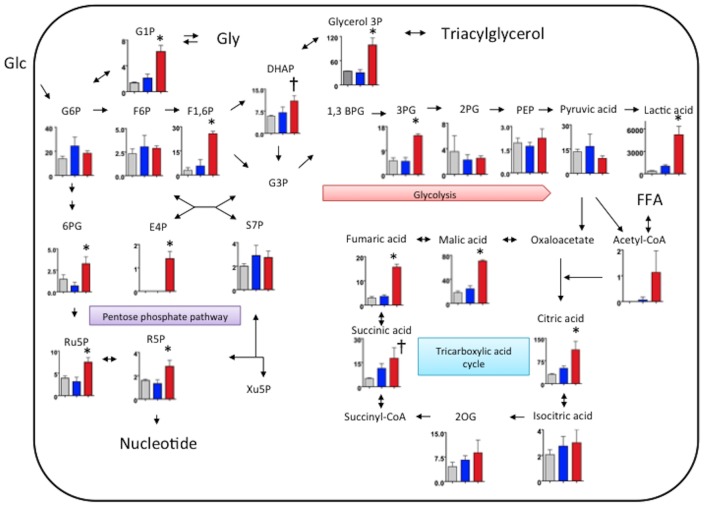
Levels of metabolites of glycolysis, the pentose phosphate pathway, tricarboxylic acid cycle and glyconeogenesis/glycogenolysis in rabbit iliac-femoral arteries.Gray, blue and red bars: iliac-femoral arteries that were not injured (conventional diet), and those with SMC-rich (conventional diet) and macrophage-rich (0.5% cholesterol diet) neointima, respectively (n = 3 for all). Metabolite levels are expressed as nmol/g. *p<0.05 vs. other groups, †p<0.05 vs. non-injured femoral artery. 1,3BPG, 1,3-bisphosphoglycerate; 2PG, 2-phosphoglyceric acid; 3PG, 3-phosphoglyceric acid; 2OG, 2-oxoglutaric acid; 6PG, 6-phosphogluconic acid; DHAP, dihydroxyacetone phosphate; E4P, erythrose 4-phosphate; F1-6P, fructose 1,6-diphosphate; F6P, fructose 6-phosphate; FFA, free fatty acid; G1P, glucose 1-phosphate; G3P, glyceraldehyde 3-phosphate; G6P, glucose 6-phosphate; Glu, glucose; Gly, glycogen; PEP, phosphoenolpyruvic acid; R5P, ribose 5-phosphate; Ru5P, ribulose 5-phosphate; S7P, sedoheptulose 7-phosphate; Xu5P, xylulose 5-phosphate.